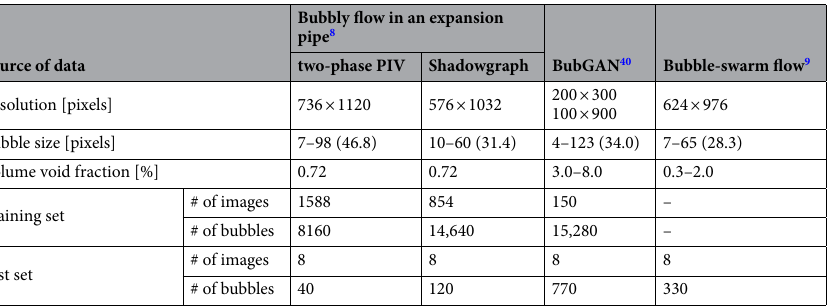
Table 1. Details for training and test datasets. The numbers in the bracket denote the averaged bubble size.